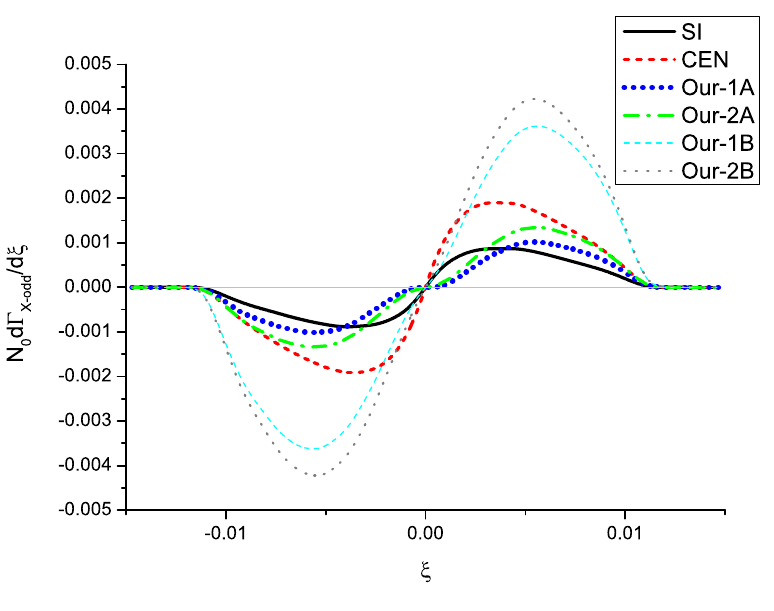
Figure 8 . Distributions of the triple-product asymmetry A ξ with E cut tion factor is taken as N 0 = 1 / Γ in figure 5.